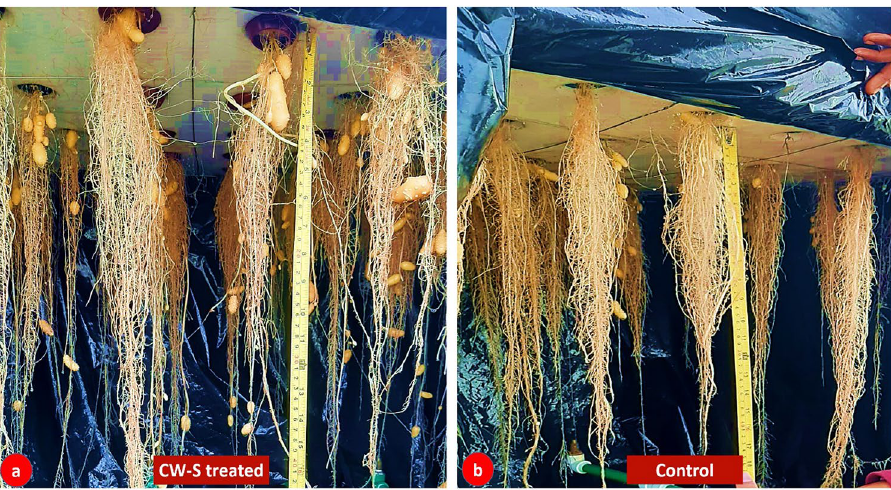
Figure 6. Root and stolon development inside an aeroponic system. ( a ) Potato plantlets treated with CW–S. ( b ) Potato plantlets under